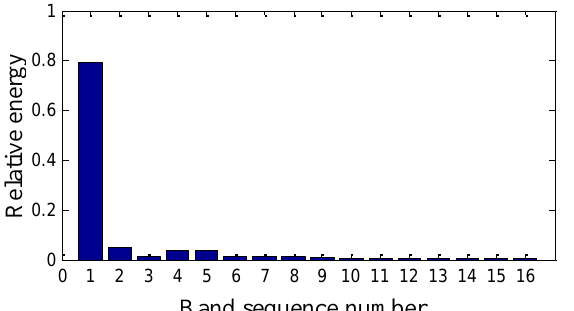
Figure 20. The sensor-dependent signal’s relative energy distribution in level 4 after maintenance.